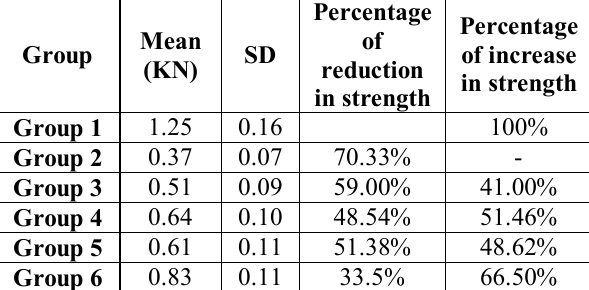
Table 1: Mean values, standard